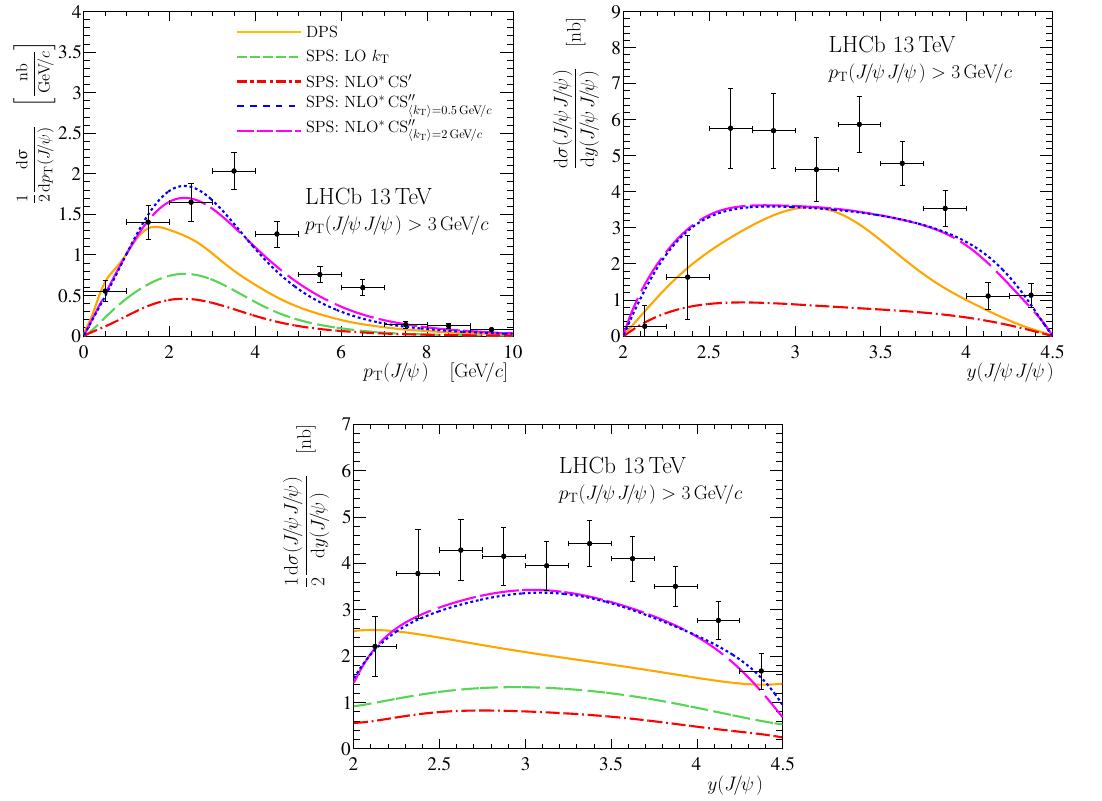
Figure 7. Comparisons between measurements and theoretical predictions with p T ( J= J= ) > 3 GeV =c for the di(cid:11)erential cross-sections as functions of (top left) p T ( J= ), (top right) y ( J= J= ) and (bottom) y ( J= ). The (black) points with error bars represent the measurements.